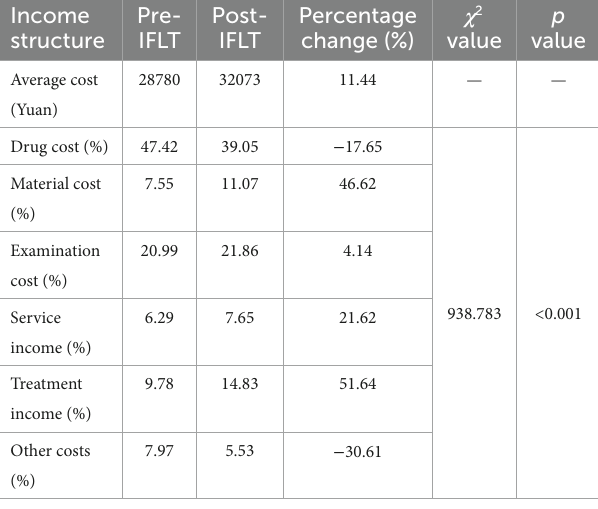
TABLE 3 Comparison of clinical income structure of the organ transplant department between the pre- and post-IFLT periods. Income